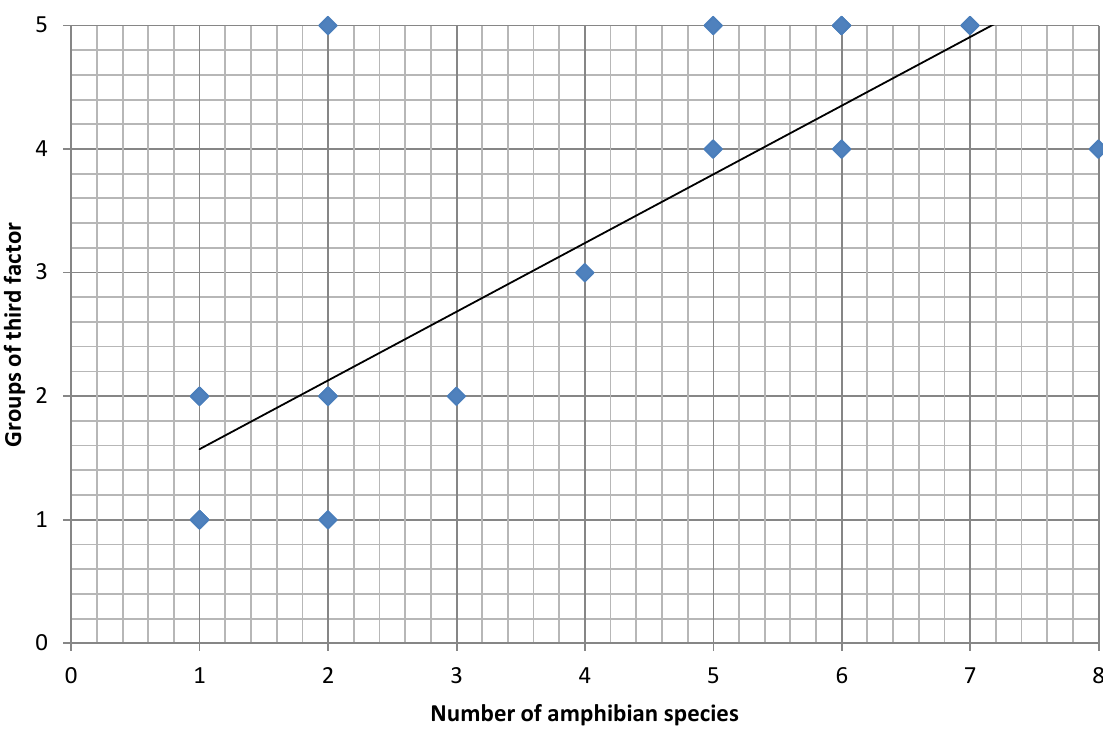
Fig. 3. Correlogram of the number of amphibian species and groups of the percentage share of the open space around water